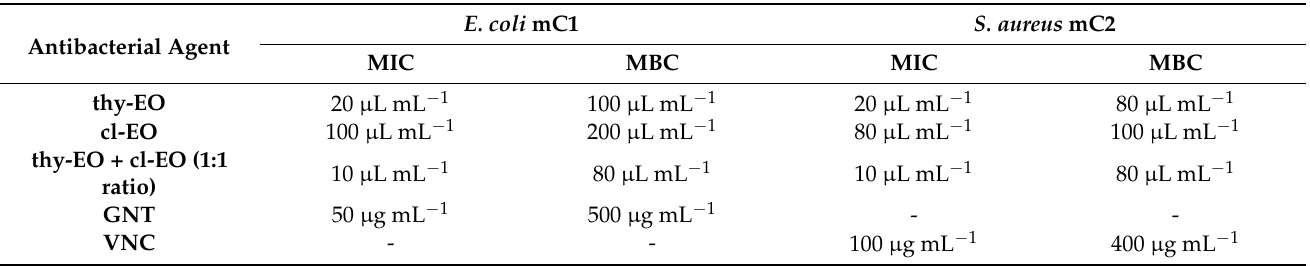
Table 2. Quantitative evaluation of in vitro antibacterial activity of thyme and cloves essential oils, individually used and in binary combination, against Escherichia coli and Staphylococcus aureus food